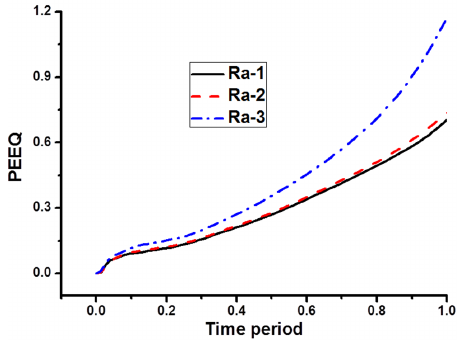
Figure 15. Load time ‐ history of maximum equivalent plastic strain.